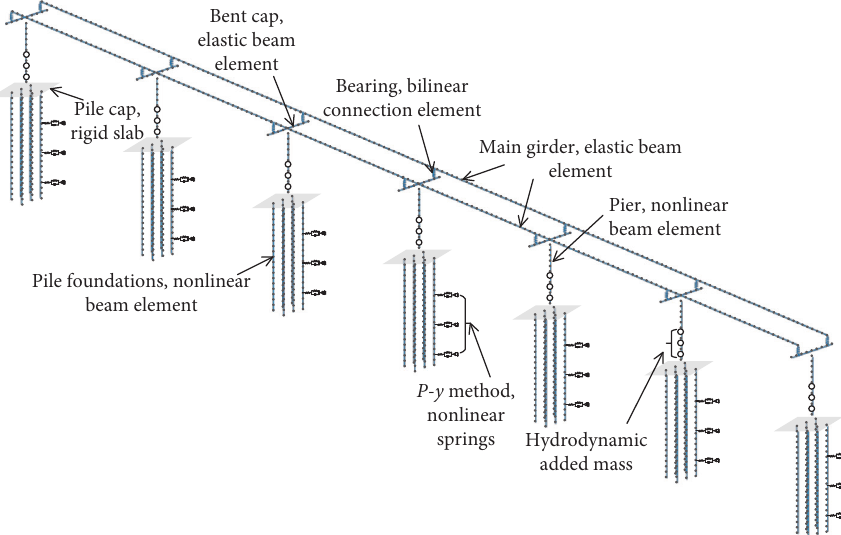
Figure 3: Finite element model of the example.